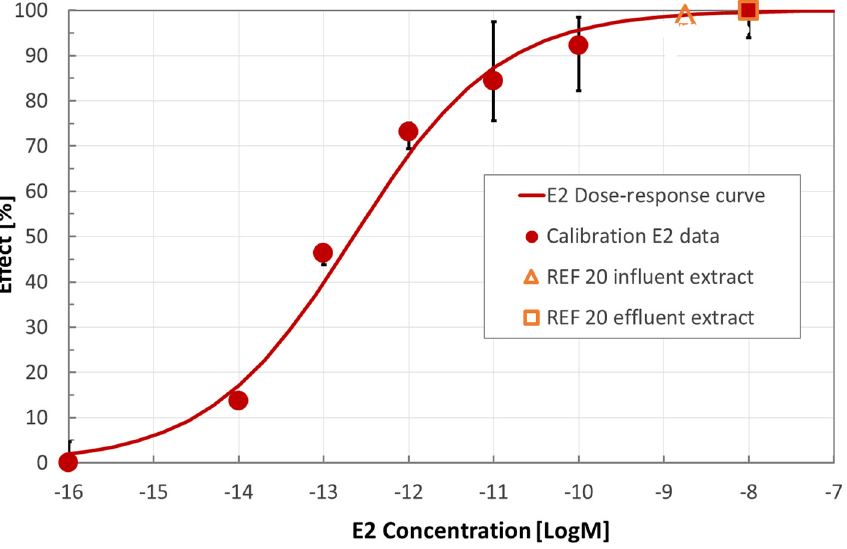
Figure 2. Estrogenic activity was assessed on MCF-7 mammary cells exposed to different concentrations of E2 and compared with REF 20 samples of influent and effluent wastewater. The assay was conducted in triplicate: error bars show maximum and minimum values.